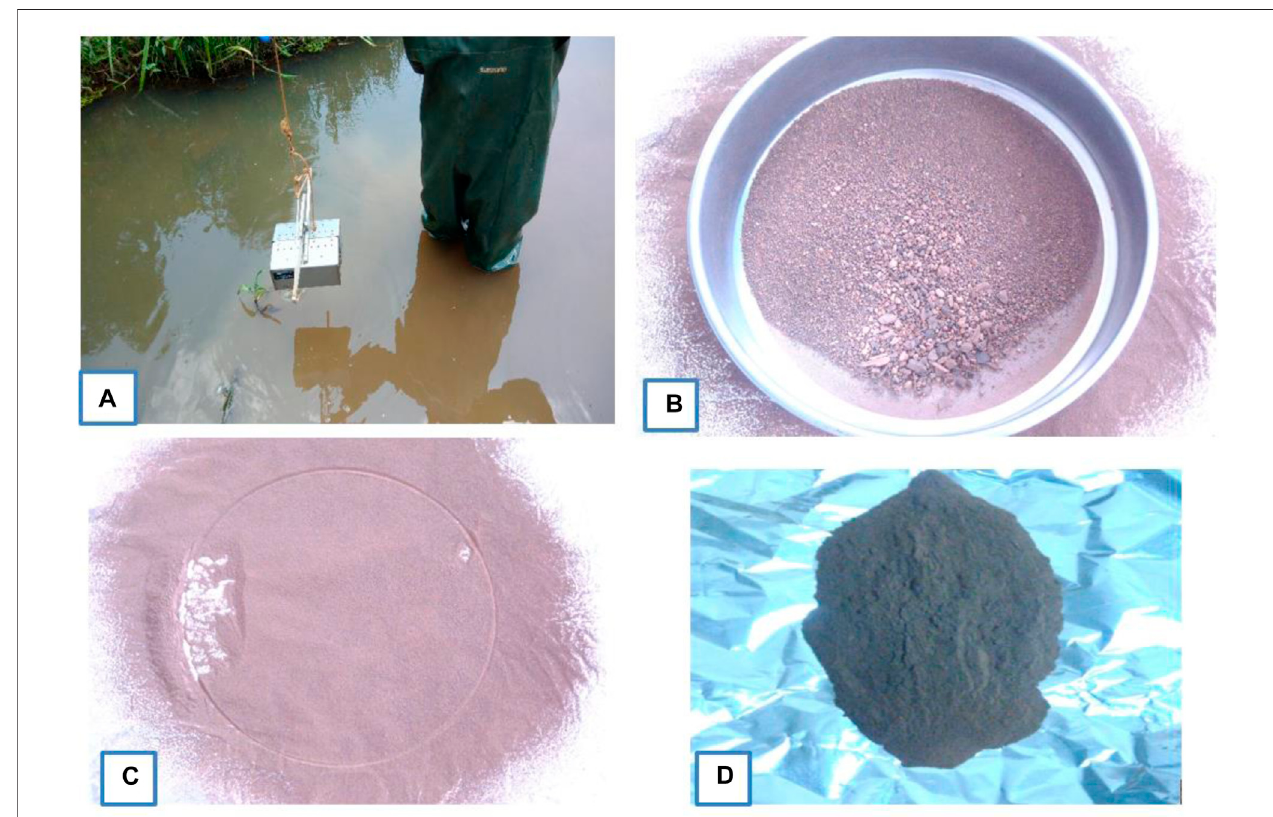
FIGURE 2 | Sample collection and preparation of sediment samples in Awetu watershed streams.